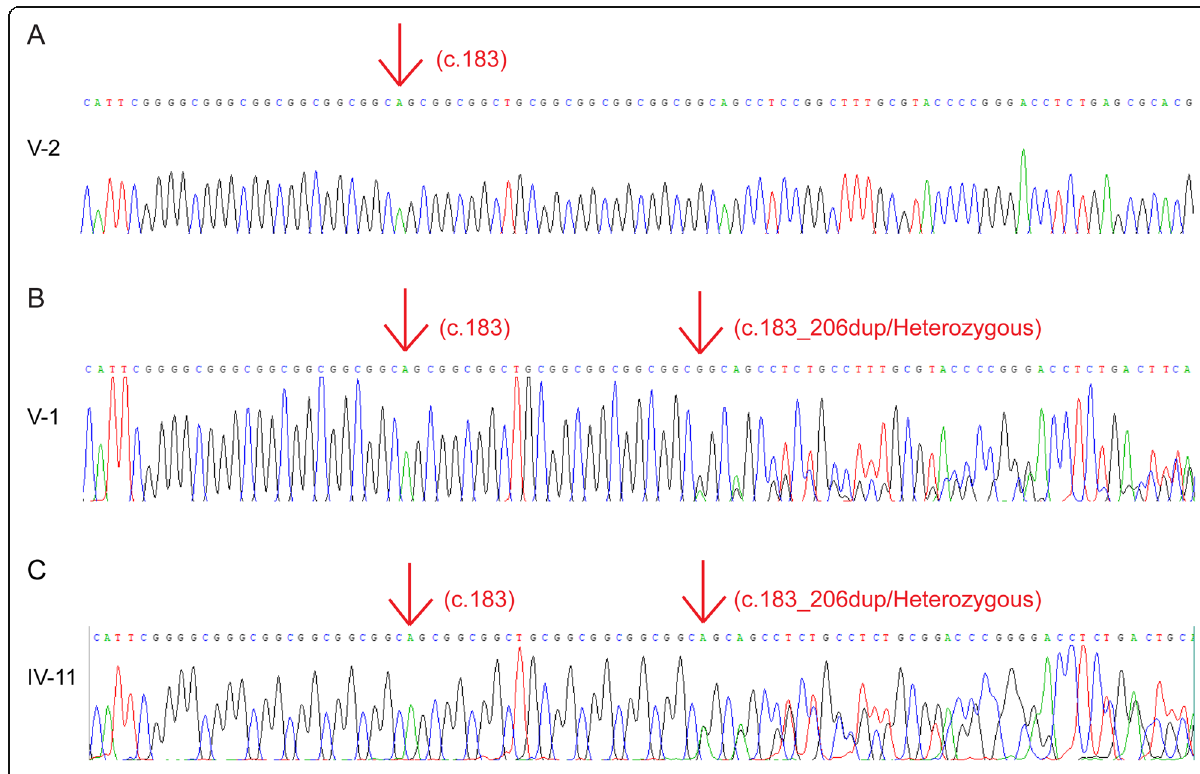
Fig. 4 Sequence analysis of HOXD13 mutation in the Chinese family. a , Sanger sequencing result of the unaffected member (V-2) done after PCR showing no double peaks. b , Sanger sequencing result of the diseased (V-1) done after PCR showing double peaks at duplication site. c , Sanger sequencing result of the affected member (IV-11) done after PCR showing double peaks at duplication site